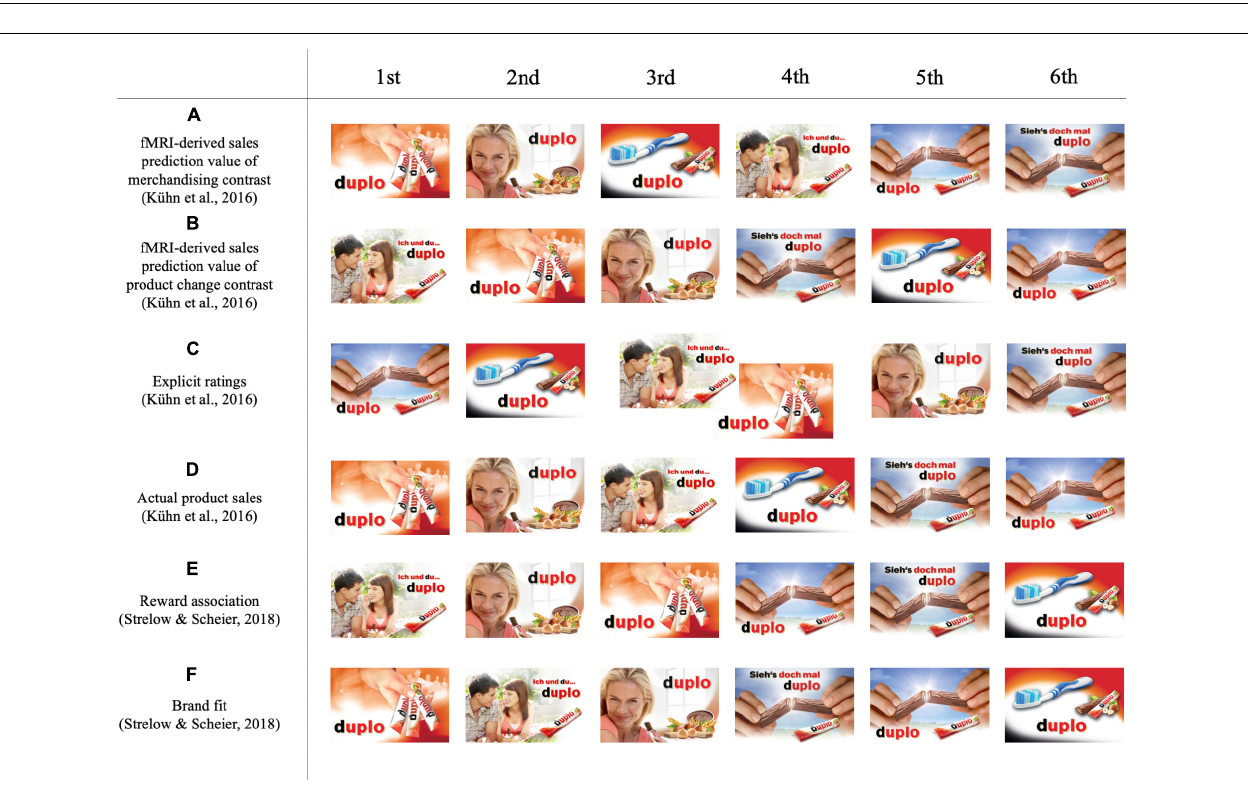
FIGURE 1 | Merchandising elements of the product ‘duplo’. The six merchandising elements were used in prior studies (Kühn et al., 2016; Strelow and Scheier, 2018) and the current study, including: (A) a woman eating a ‘duplo’ bar, used at the PoS from 1995 to 2015; (B) hands holding a ‘duplo’ bar, representing a TV campaign that had been on air for 6 months from 2011 to 2012; (C) a group of people and three ‘duplo’ bars, which represented a TV campaign that had been on air for nearly 20 years between 1991 and 2010; (D) a couple with a ‘duplo’ bar and (E) hands holding a ‘duplo’ bar with text , which were not used in advertising previously, as well as (F) a toothbrush with a ‘duplo’ bar used as control merchandising element. Figure adapted from Kühn et al. (2016). Permission to reuse has been obtained.